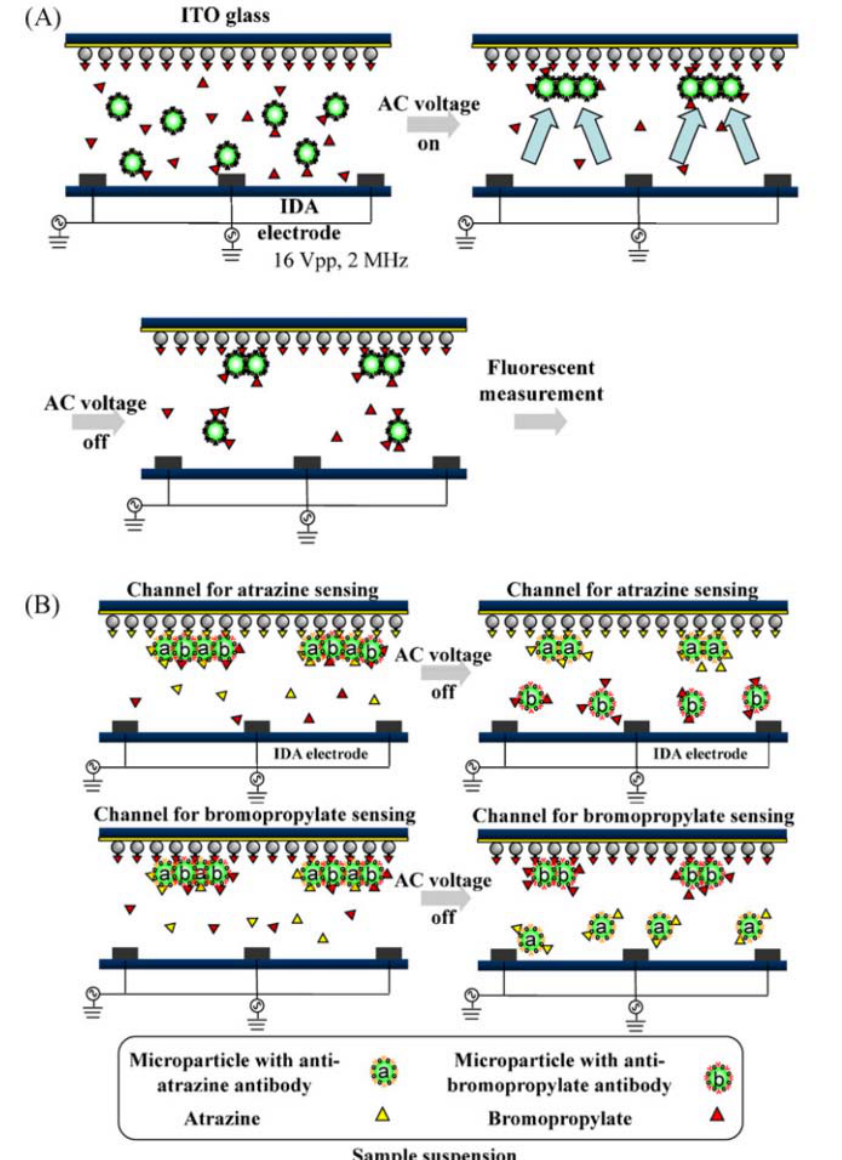
Figure 3. Schematic representation of accelerated immunosensing based on the n-DEP device. ( A ) Single analyte sensing system and ( B ) multi-analyte system usingthe n-DEP device with two channels modi fi ed with different competitors. Arrows in the